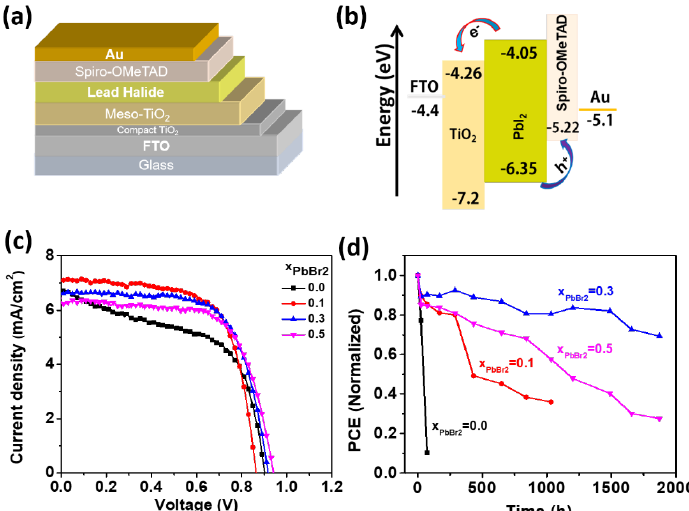
Figure 6. ( a ) A schematic of the device structure of the fabricated lead halide solar cell, and ( b ) the corresponding energy levels of each layer used in the device. ( c ) J-V curves of the lead halide solar cells fabricated at x = 0, 0.1, 0.3, and 0.5, respectively. ( d ) PCE of the devices fabricated at various molar ratios as a function of storage time.